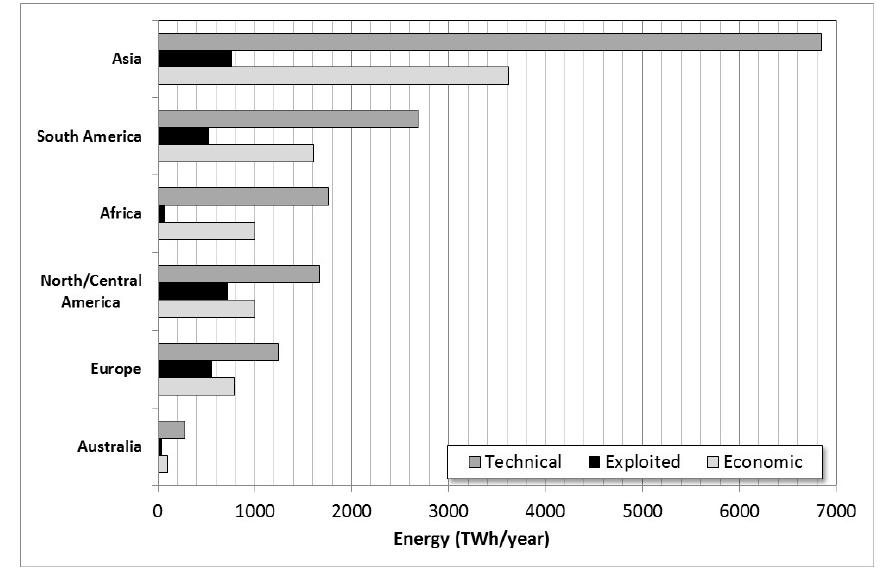
Figure 1. Worldwide hydraulic potential (adapted from [11]).